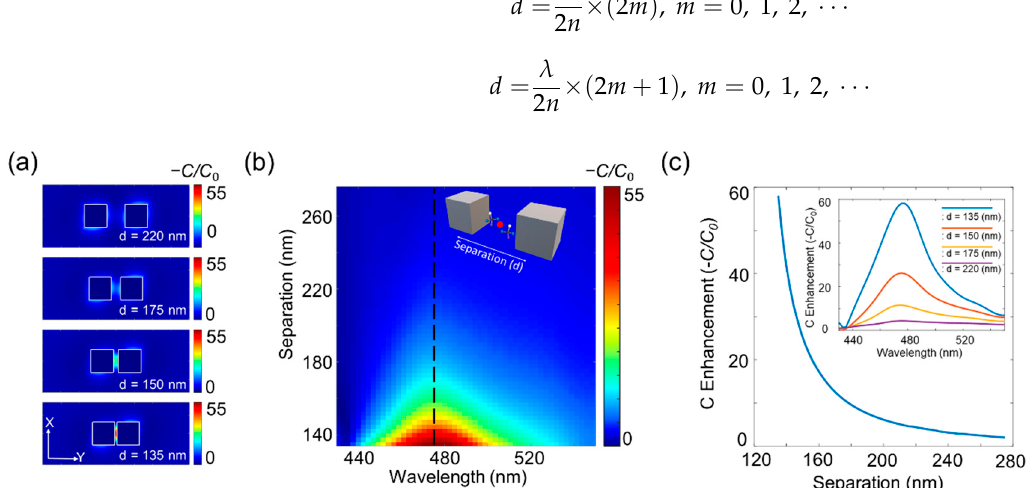
Figure 3. The enhanced optical chirality at the gap point of the Si nanoblock dimer. ( a ) Images of enhanced optical chirality at the four representative separations ( d = 220 nm, 175 nm, 150 nm, and 135 nm, from top to bottom) at the resonant wavelength of 475 nm. ( b ) Two-dimensional map of the optical C enhancement at the center of the gap in the nanoblock dimer for the various separations of the dimer. ( c ) The C enhancement for the separation of the dimer at the wavelength of 475 nm. The inset in ( c ) shows the spectrums in four representative dimers in ( a ).